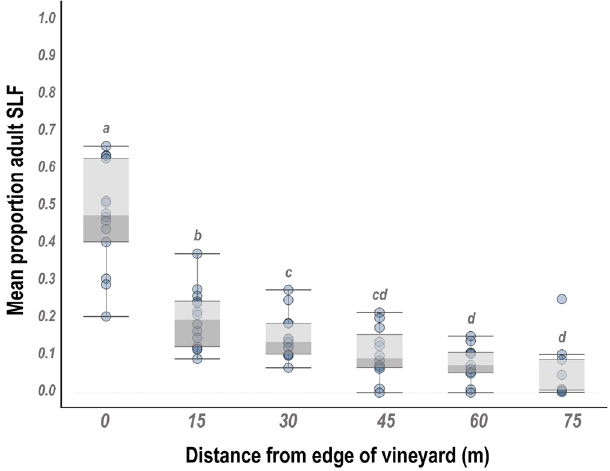
Figure 1. Mean proportion adult spotted lanternfly (SLF) found at sampling distances from vineyard edge, 0 m (at vineyard edge) to 75 m into the vineyard block. A total of 8 vineyards were sampled for adult SLF during 2018 and 2019. Bands for each distance represent 95% confidence interval. Different letters denote significant differences between distances at alpha =